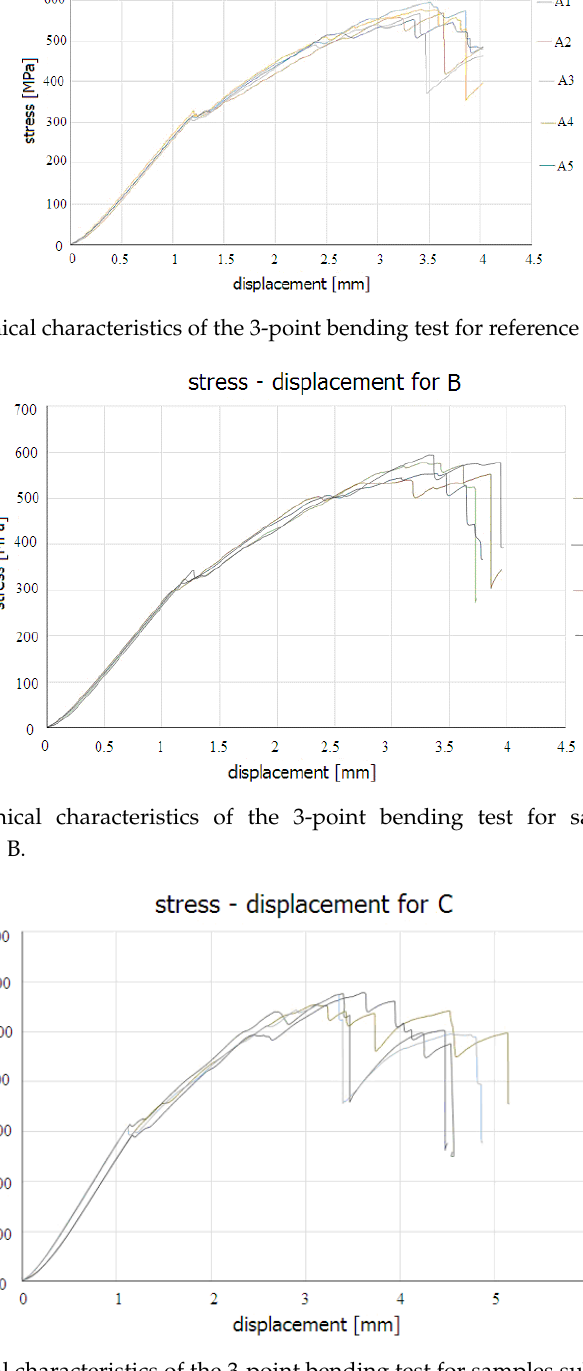
Figure 7. Mechanical characteristics of the 3-point bending test for samples subjected to high direct current (DC) voltage and temperature–group C.